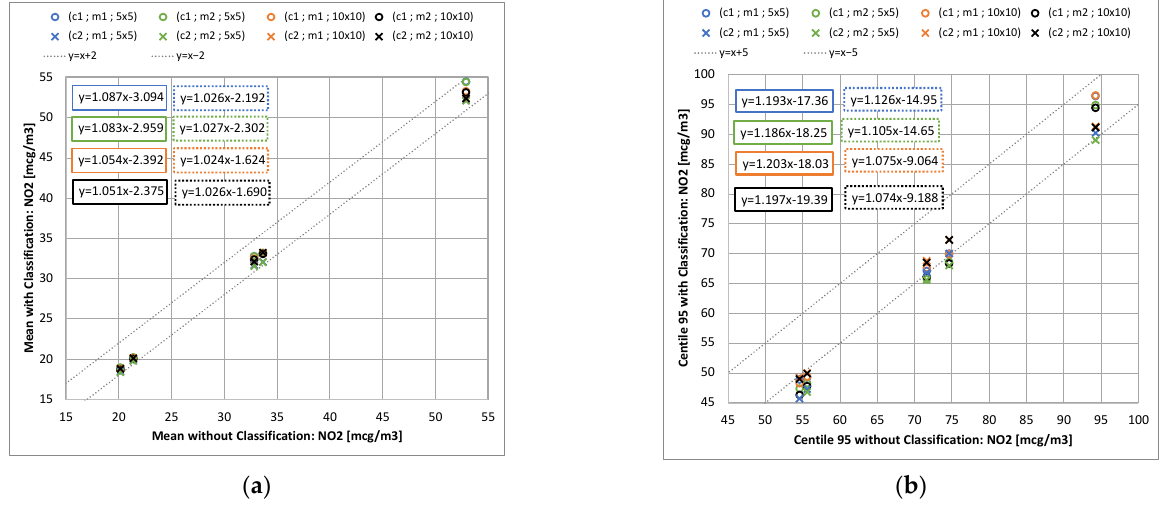
Figure 2. Comparison of annual average ( a ) and 95th percentile ( b ) with and without SOMs classification, for different configurations (c1; c2), reconstruction method (m1; m2), and number of target classes (5 × 5; 10 × 10).